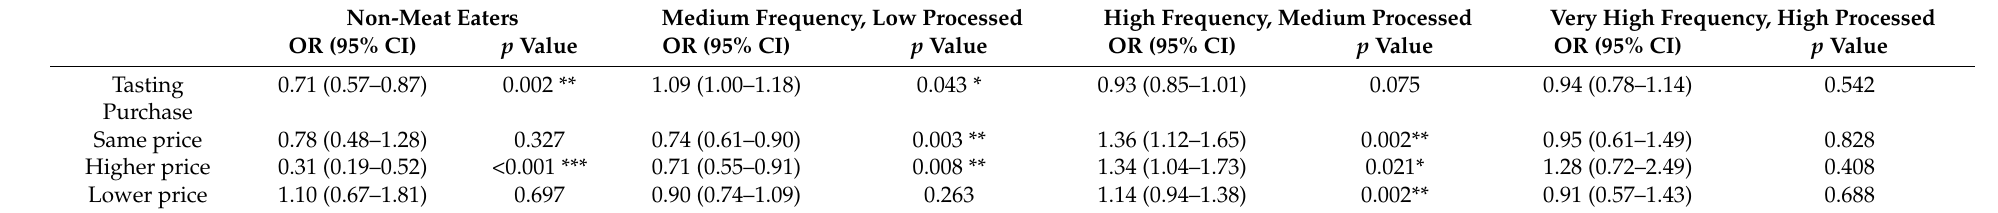
Table 6. Participants’ intentions of trying cultured